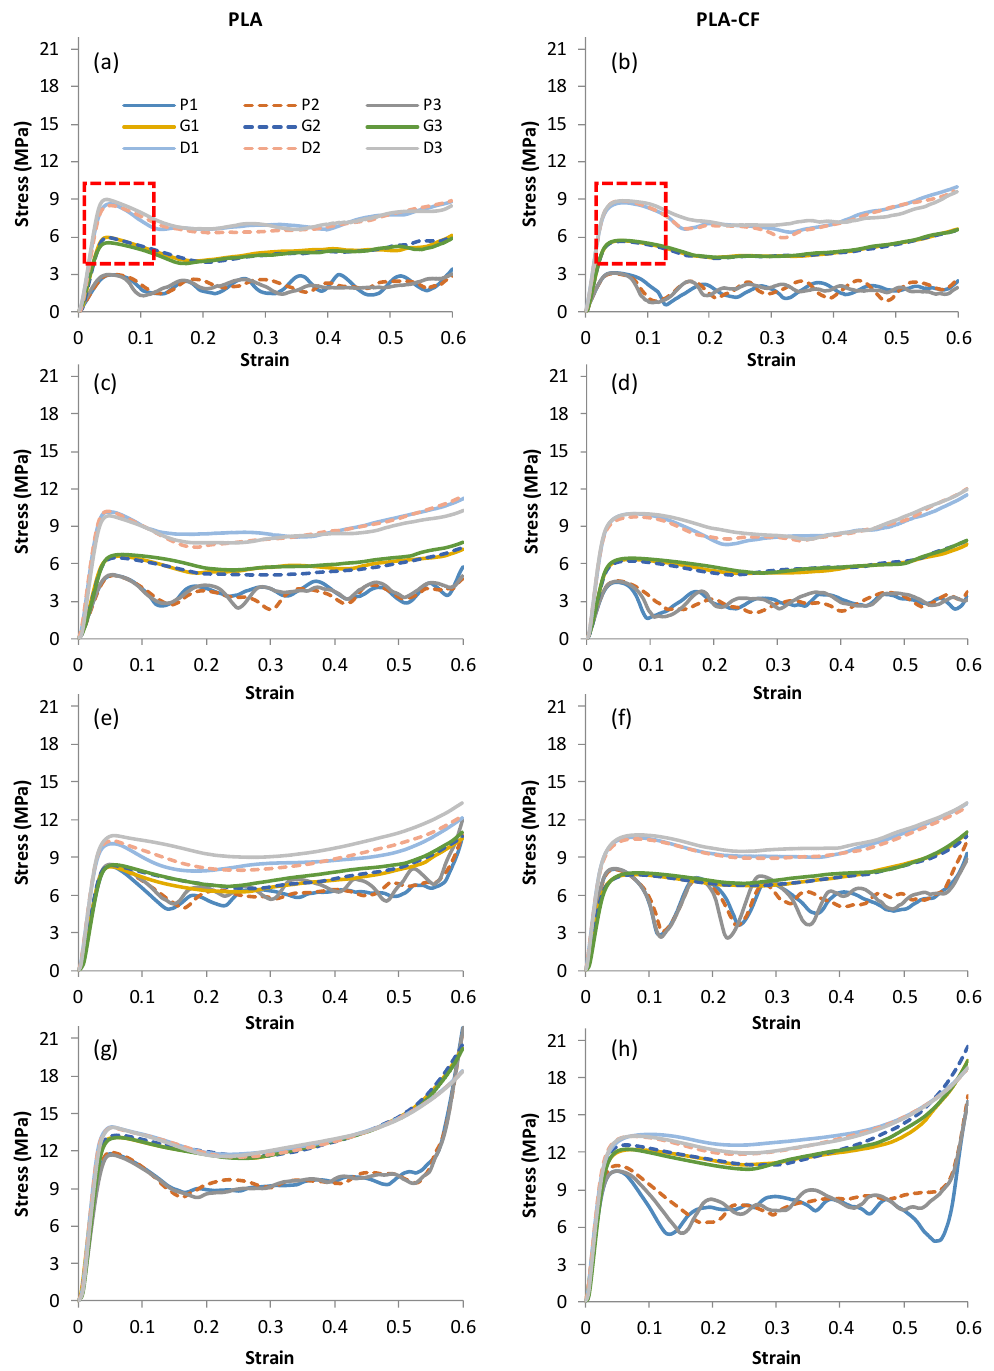
Figure 8. Stress–strain curves until 60% strain of Primitive, Gyroid, and Diamond structures at 8 mm cell size: ( a , b ) 23% RD, ( c , d ) 30% RD, ( e , f ) 37% RD, and ( g , h ) 44% RD. The red dashed boxes highlight the evident influence of CF incorporation on the plastic